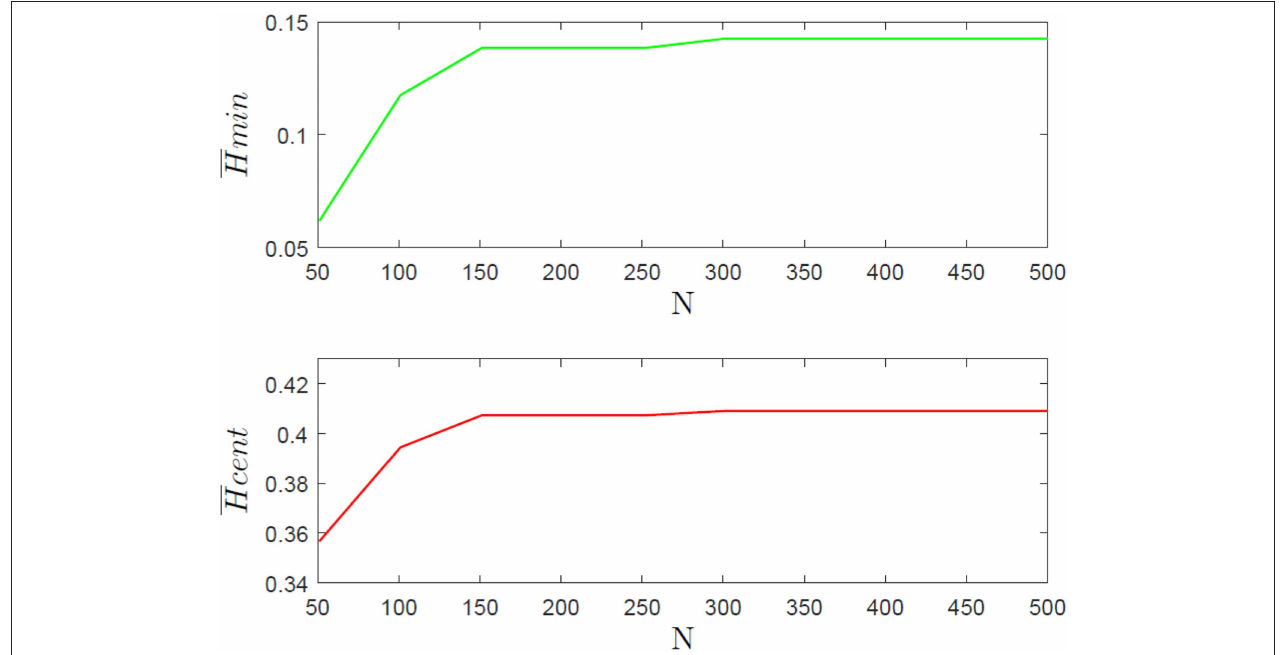
FIGURE 3 | Mesh sensitivity test with total number of nodes